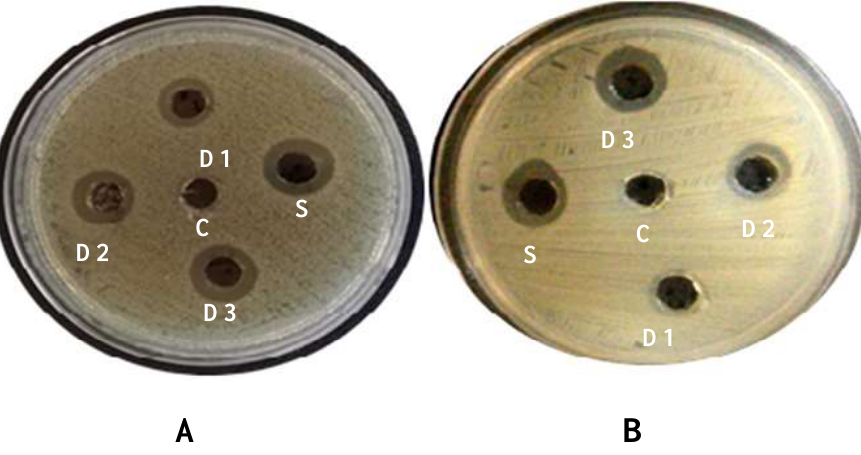
Figure 4 : The antibacterial activity of silver nitrate against (A) S. haemolyticus , (B) K . pneomonaie bacteria . Note: (S) refers to 100%, (D3) refers to 50%, (D2) refers to 25%, (D1) refers to 12.5%, (C) refers to negative control.